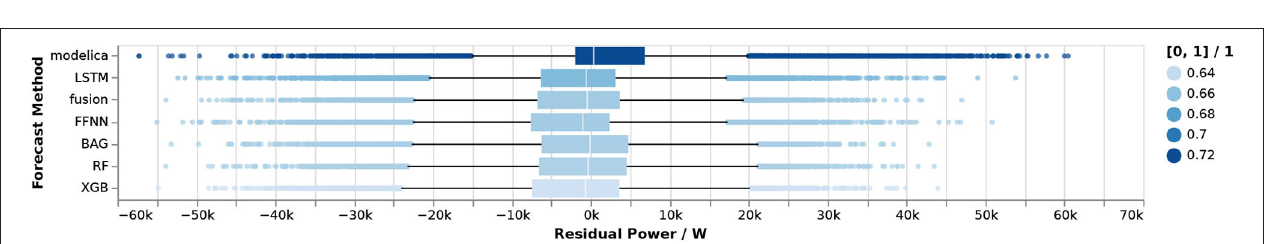
FIGURE 8 | Boxplots of residual distribution for all methods; ranked and sorted by metric mm